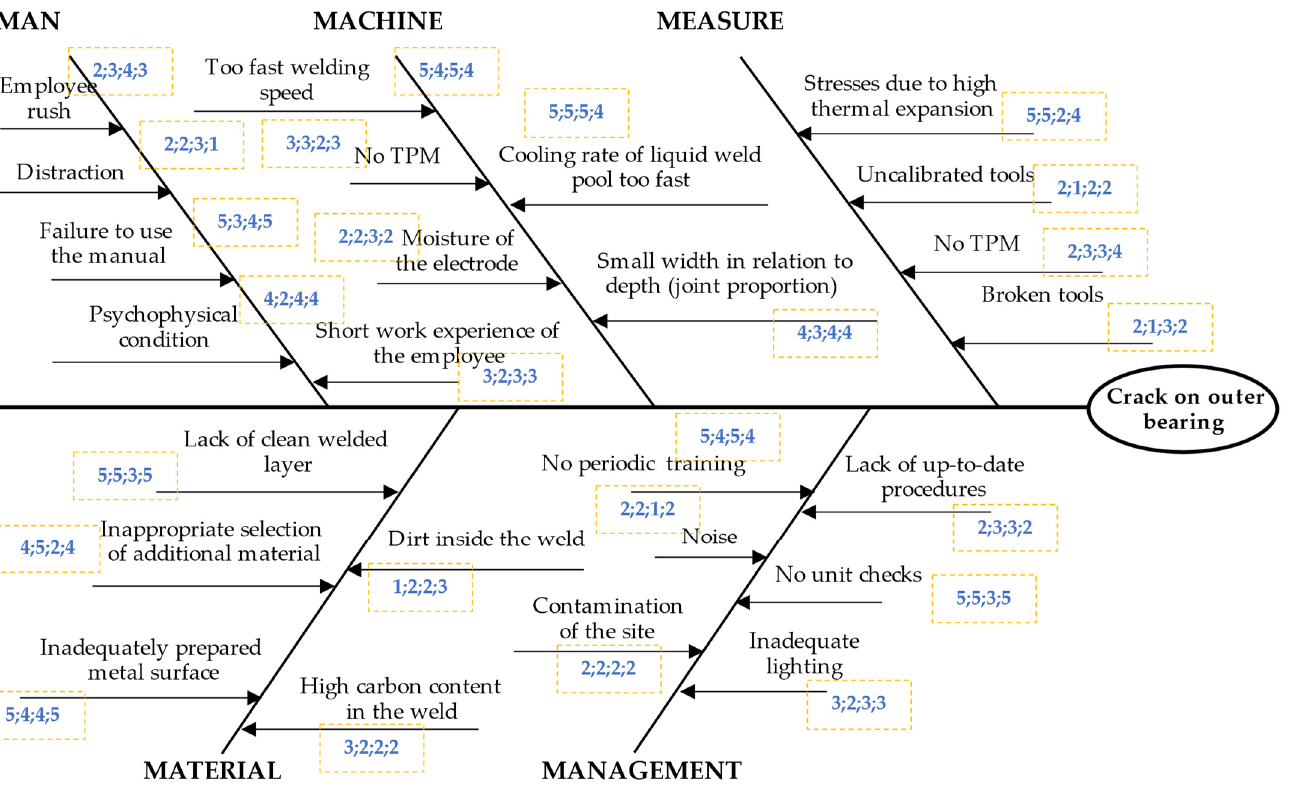
Figure 5. Ishikawa diagram for crack on the outer hull of four-point bearing to assess the importance of potential causes.